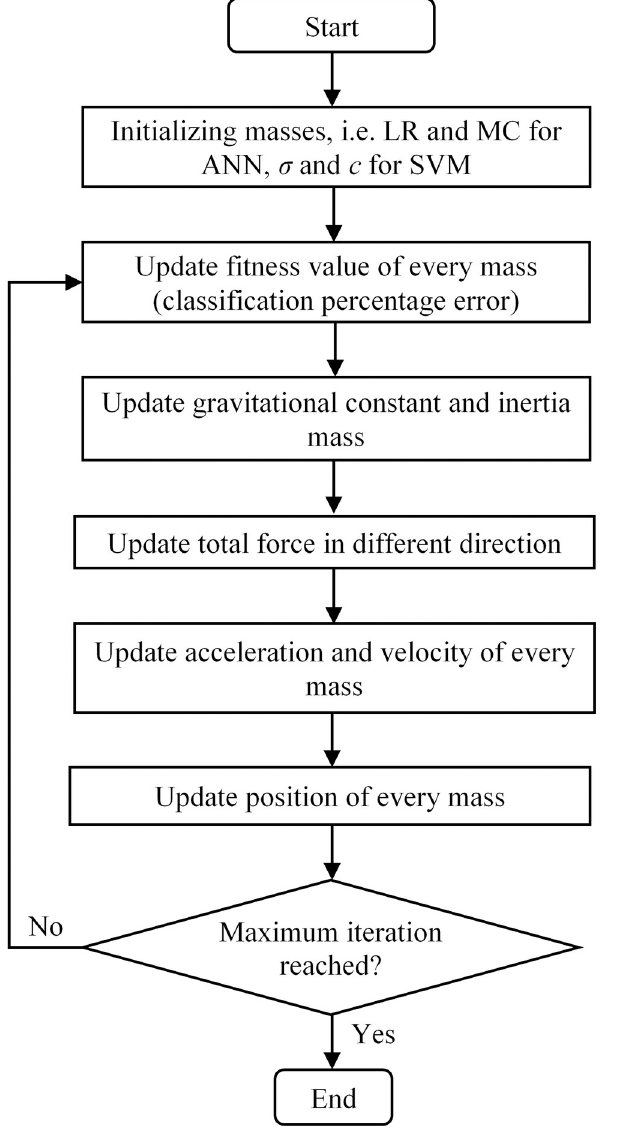
Fig 4. Flowchart of the proposed GSA-AI